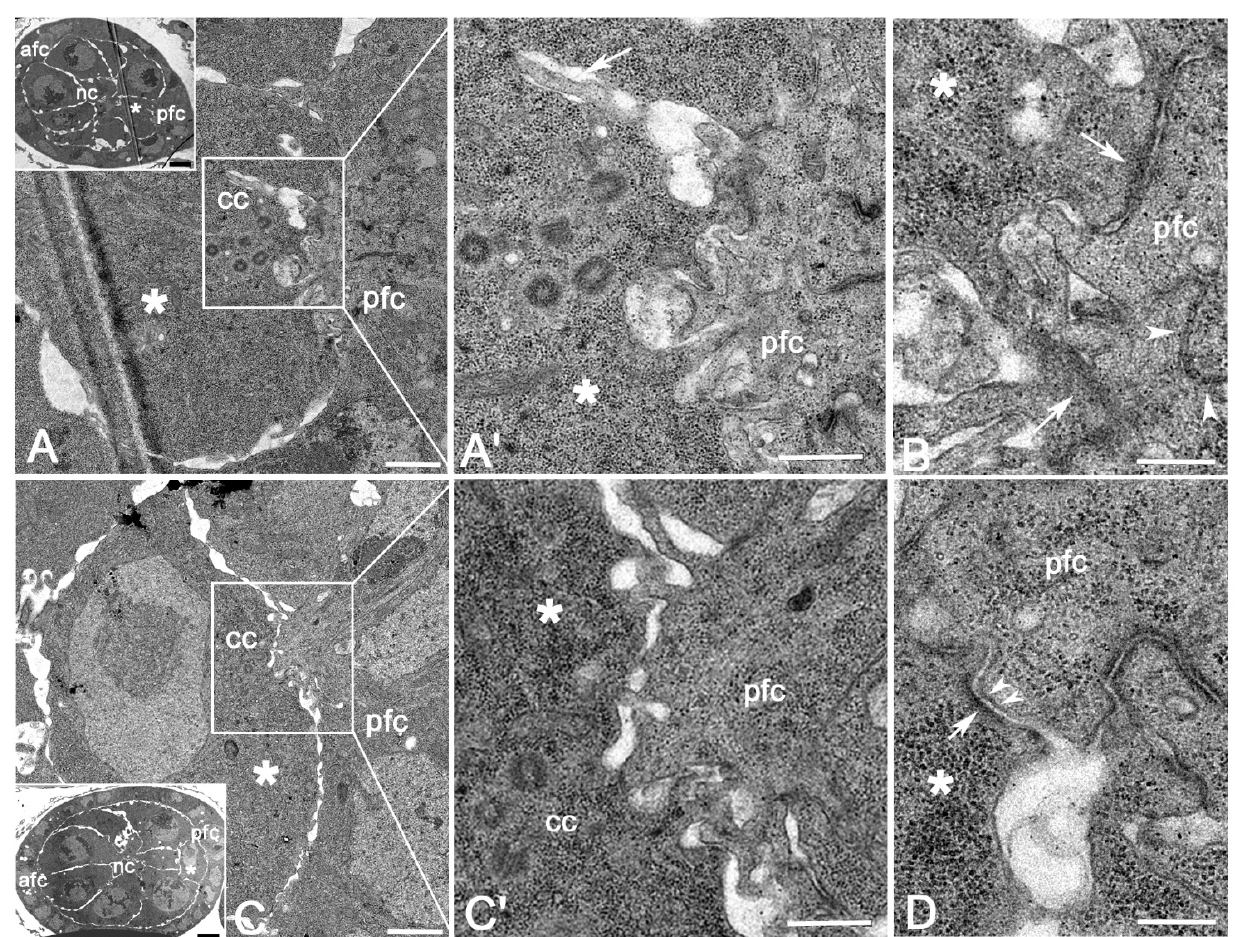
Figure 3. ( A ) Cross section of a stage 3 egg chamber and ( A’ ) detail of the posterior region of the oocyte at the level of the centriole cluster: irregular projections of the follicle cells interdigitate with opposite projections of the oocyte membrane or enter deeply in the oocyte cytoplasm (arrow). ( B ) Magnification of the posterior region of the oocyte at the level of the centriole cluster showing large contacts between the oocyte and the follicle cell membranes (arrows) and between the convoluted apical region of adjacent follicle cells (arrowheads). ( C ) Section of the posterior region of a stage 5 egg chamber and ( C’ ) detail of the interface between the follicle cells and the oocyte: the more prominent protrusions of both the follicle and the oocyte membranes are restricted to the region in front of the centriole cluster. ( D ) Magnification of an AJ between the oocyte and the facing follicle cells showing a dense material only present on the oocyte side of the plasma membrane (arrow) and distinct thin bridges (arrowheads) in the space between the membranes of the adjacent cells. asterisk, oocyte; cc, centriole cluster; nc, nurse cells; afc, pfc, anterior and posterior follicle cells. Scale bars: ( A – C ), 1 μ m; ( A’C’ ), 0.3 μ m; ( B , D ), 2 μ m; inset ( A ), 3 μ m, inset ( C ), 4 μ m.